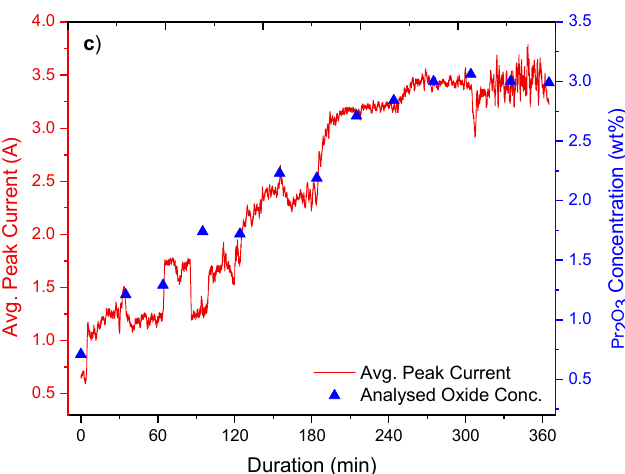
Figure 4. Data from the dissolution of praseodymium oxides (Pr 2 O 3 and Pr 6 O 11 ) in equimolar NdF 3 –LiF and PrF 3 –LiF electrolytes: ( a , b ) data from the dissolution of Pr 2 O 3 and Pr 6 O 11 in equimolar NdF 3 –LiF electrolytes as in experiments 4 and 5, respectively; ( c ) data from the dissolution of Pr 2 O 3 in an equimolar PrF 3 –LiF electrolyte as in experiment 6.